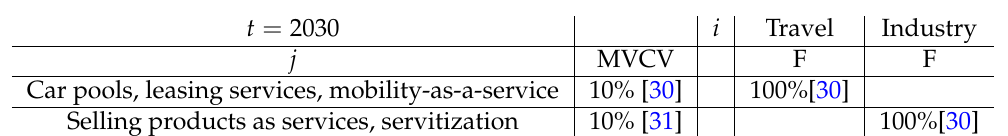
Table 9. Smart Services saving ICT Technologies.